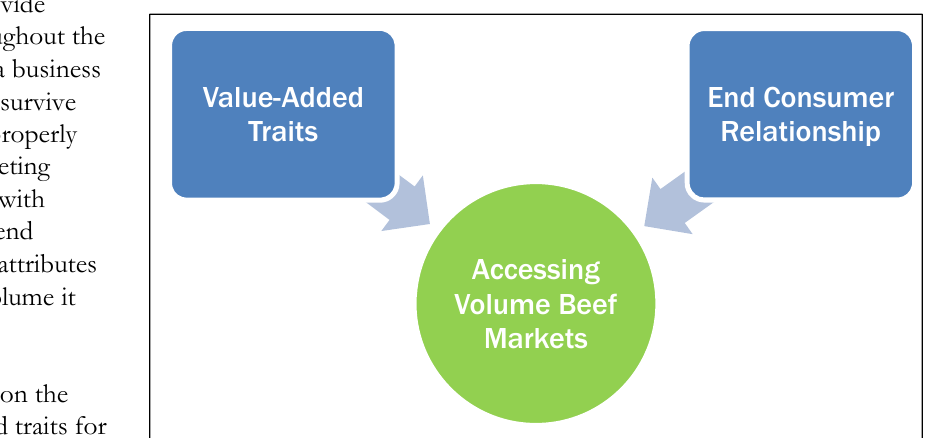
Figure 2. Tallgrass Prairie Producers Cooperative